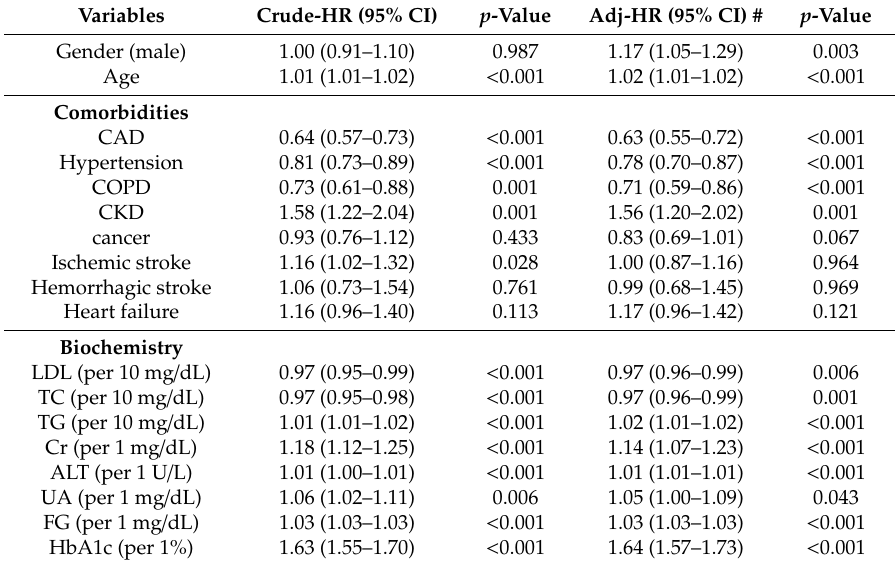
Table 2. Hazard ratio (HR) of baseline characteristics in new-onset diabetes mellitus